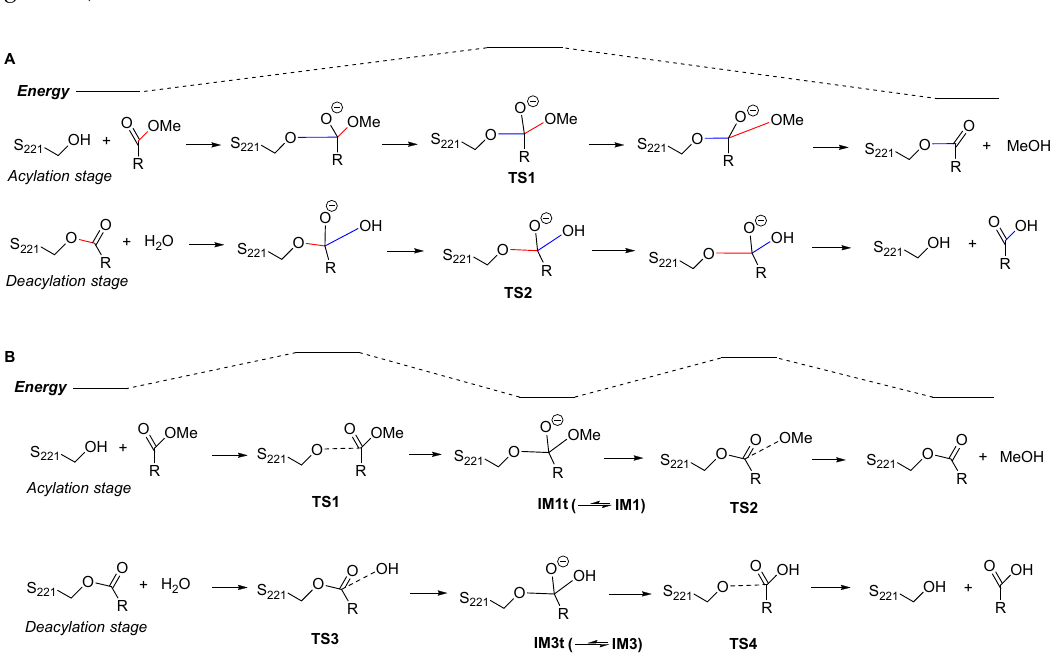
Figure 5. A brief comparison of previously reported cocaine hydrolysis mechanism ( A ) and our results ( B ). The blue bonds are newly formed bonds whose length is continuously decreasing, and the red bonds are bonds to be broken whose length is continuously increasing. For simplicity, the proton transfer and the involved catalytic residues (H468 and E354) are not shown